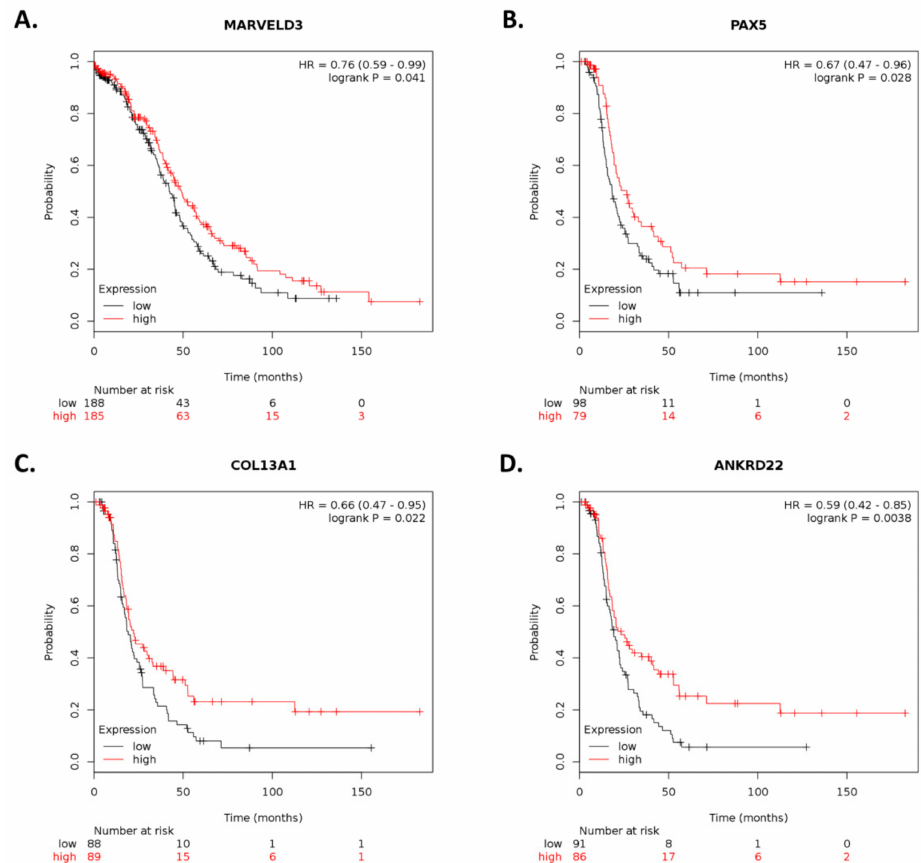
Figure 8. Kaplan–Meier plots for gene expression-based overall survival and relapse-free survival analysis. Survival plots of ovarian cancer patients were generated using Kaplan–Meier plotter (KM plotter). Overall survival (OS) of patients with ovarian cancer stratified by expression levels of ( A ) MARVELD3 is shown based on RNA-Seq data. Relapse-free survival (RFS) of patients with ovarian cancer stratified by expression levels of ( B ) PAX5 , ( C ) COL13A1 , and ( D ) ANKRD22 is shown based on RNA-Seq data. p -values < 0.05 were considered to be statistically